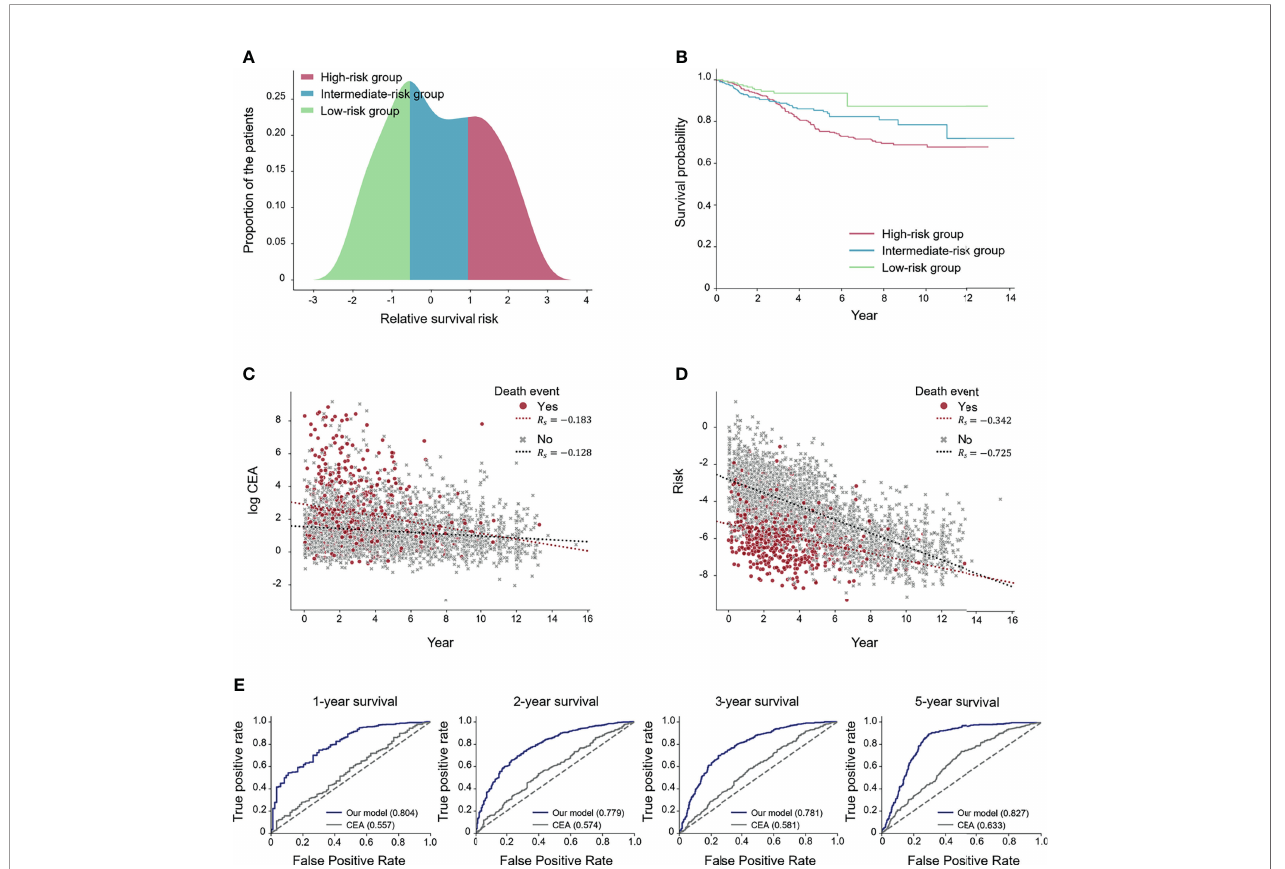
FIGURE 2 | Performance of the deep-transfer-learning-based survival prediction model. (A) Distribution of predicted risks of patients in the test set. The patients were divided into high-, medium-, and low-risk groups according to the predicted risks. (B) Kaplan – Meier survival graph of each risk group. (C) Visualization of the association between log carcinoembryonic antigen (CEA) values and survival times. (D) Visualization of the association between the predicted risks and survival times. (E) Receiver operating characteristic (ROC) curves for comparing CEA and the predicted risk on N-year survival prediction. The values of each area under the ROC (AUROC) for both the serial model and the CEA are shown ( R s : Spearman ’ s correlation coef fi